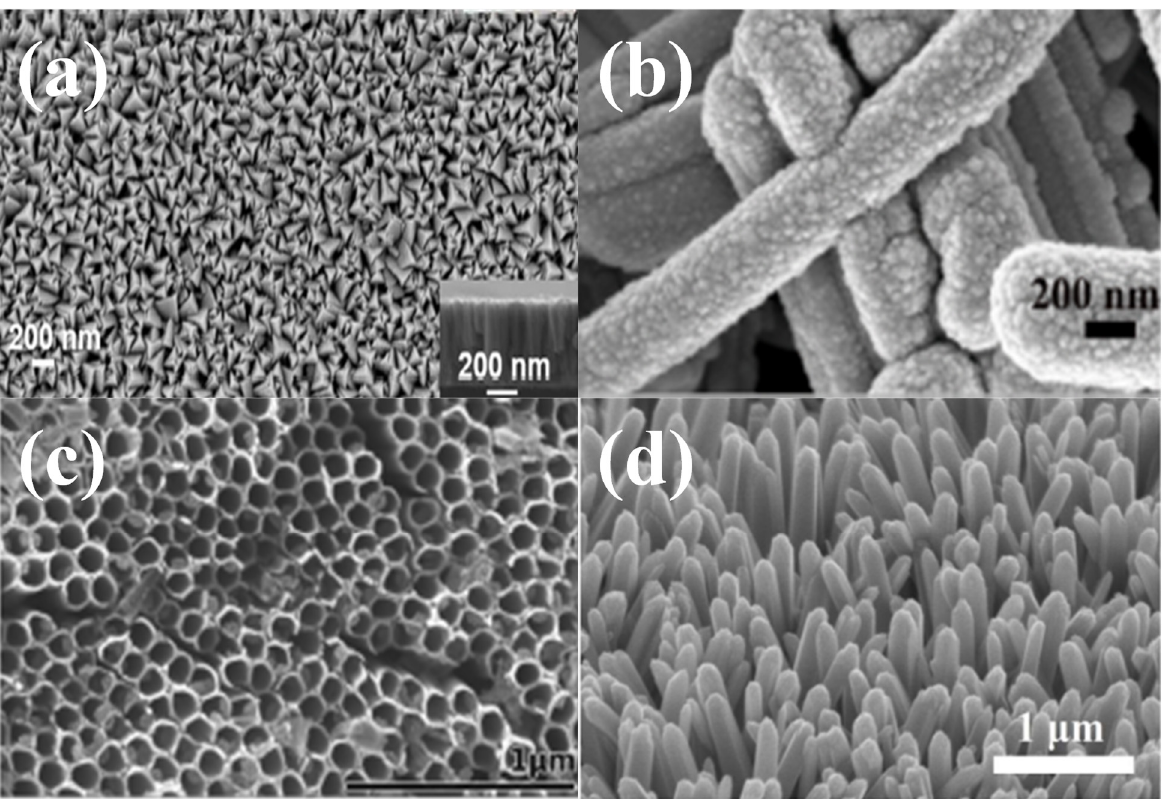
Figure 1. ( a ) FE-SEM image of nanopyramid shaped TiN thin film synthesized by sputtering process [45], reproduced with permission, copyright 2018, Elsevier. ( b ) Magnified SEM image of rod-like Si 60 NWs–TiN electrode [46], reproduced with permission, copyright 2021, Elsevier. ( c ) Mesoporous SEM images of the top surface view of TiN nanotube arrays [47], reproduced with permission, copyright 2014, Royal Society of Chemistry. ( d ) SEM image of the TiN nanowire arrays on the carbon nanotube fibers [48], reproduced with permission, copyright 2018, American Chemical Society.